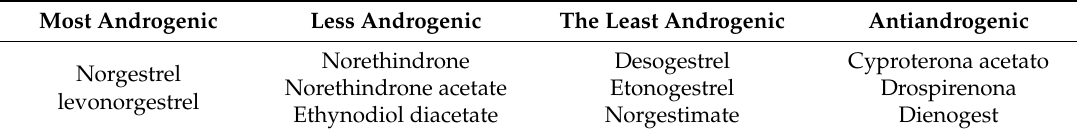
Table 2. Classification of progestogens used in contraception according to their androgenic potency. Most Androgenic Less Androgenic The Least Androgenic Antiandrogenic Cyproterona acetato Norethindrone Desogestrel Norgestrel Norethindrone acetate Etonogestrel Drospirenona levonorgestrel Ethynodiol diacetate Norgestimate